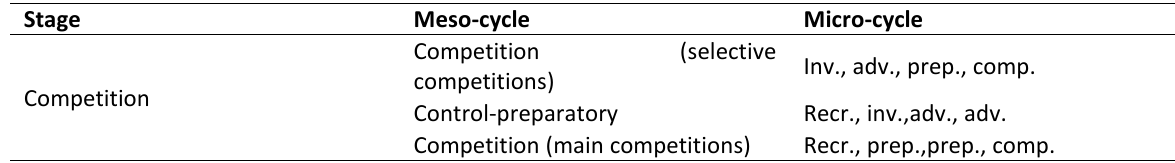
Table 3. Scheme of EG training in competition period